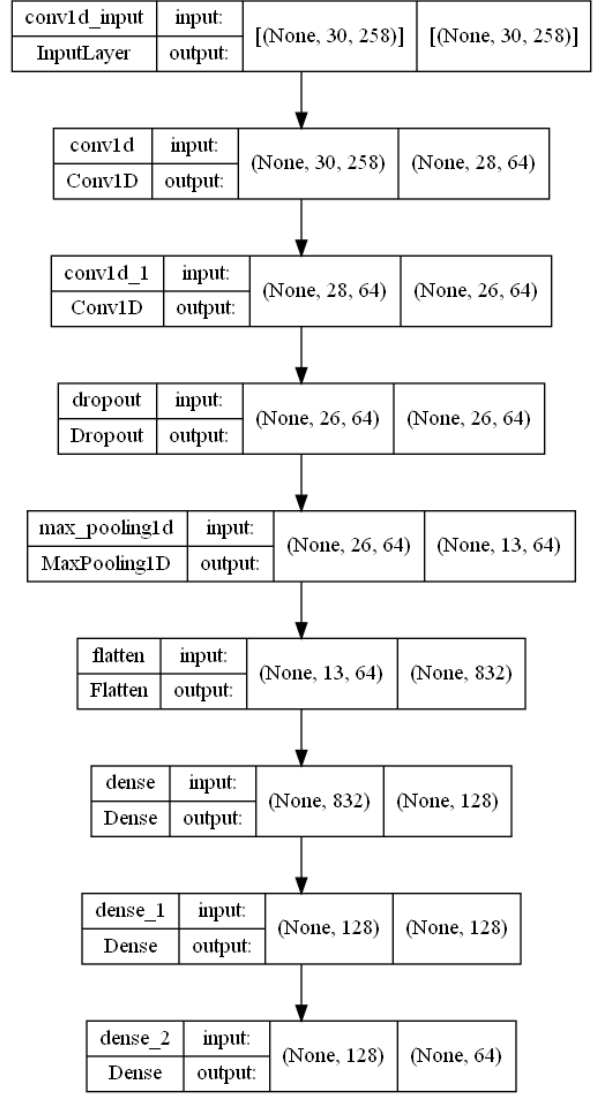
Figure 11. 1D CNN model structure. Table 3. Collection of values that have been tried with model